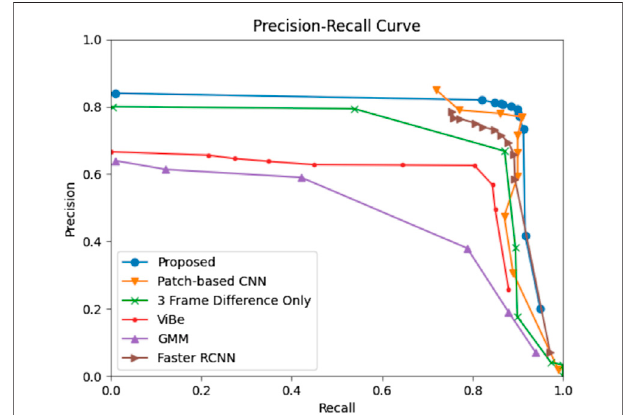
FIGURE 5 | Sample object detection.